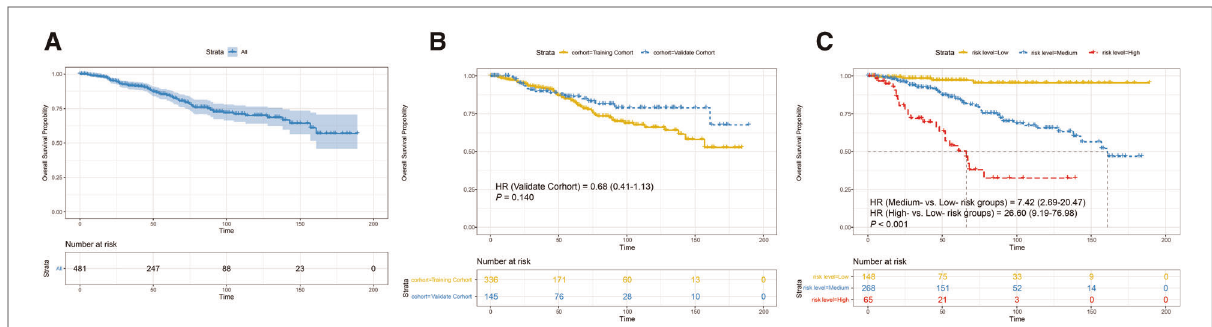
FIGURE 7 Survival analysis ( A ) in the total cohort. Subgroup analyses strati fi ed ( B ) by cohort; ( C ) by risk level. HR, hazard ratio. P -value was calculated by log-rank